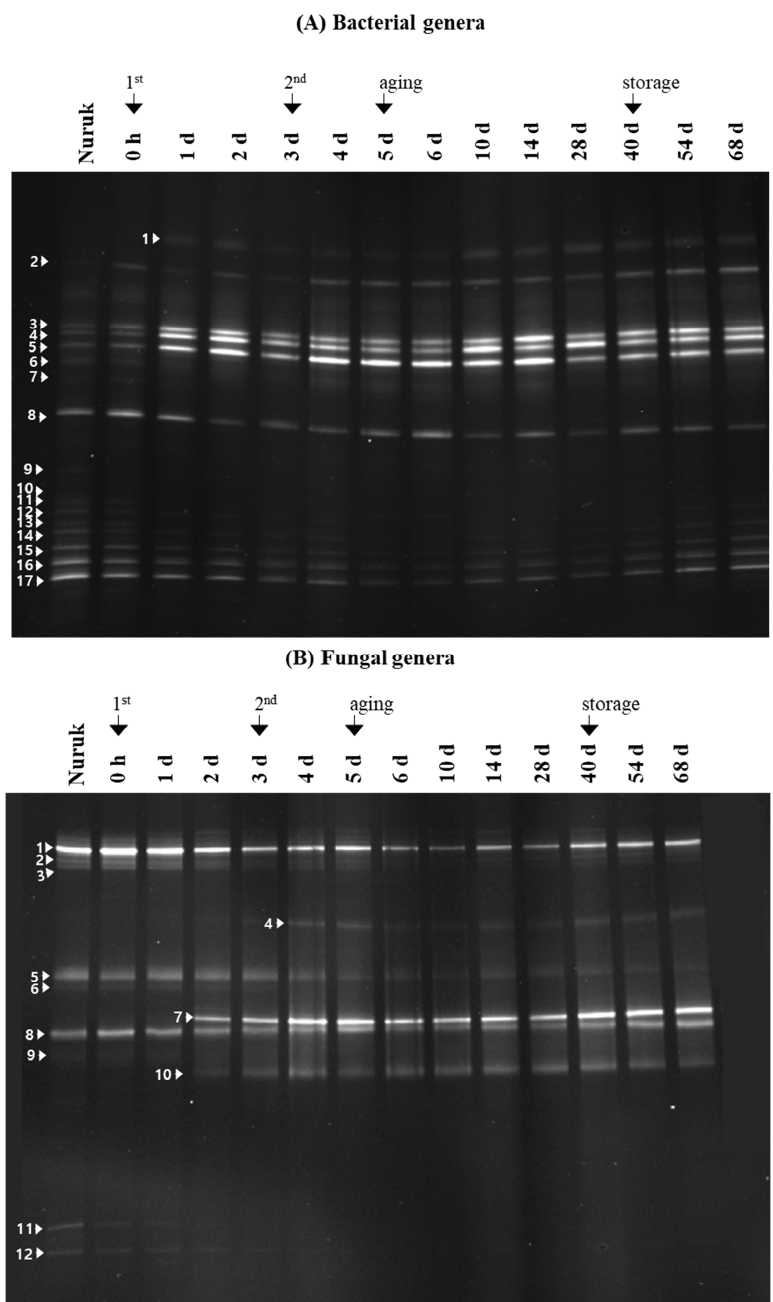
Figure 5. DGGE fingerprints of bacterial 16S rDNA ( A ) and eukaryokic 26S rDNA ( B ) during Korean traditional rice wine fermentation. The closest relatives of the fragments sequenced compared to the sequences retrieved from the GenBank database are as follows: (A1) Lactiplantibacillus plantarum (AY590777), (A2) Lactilactobacillus sakei (JN851763), (A3) Lactilactobacillus curvatus (JQ247525), (A4) Liquorilactobacillus satsumensis (AB362684), (A5) Pediococcus acidilactici (AB627837), (A6) Erwinia sp. (KC853200), (A7) Pantoea sp. (DQ122375), (A8) Pediococcus pentosaceus (AB236655), (A9) Pantoea